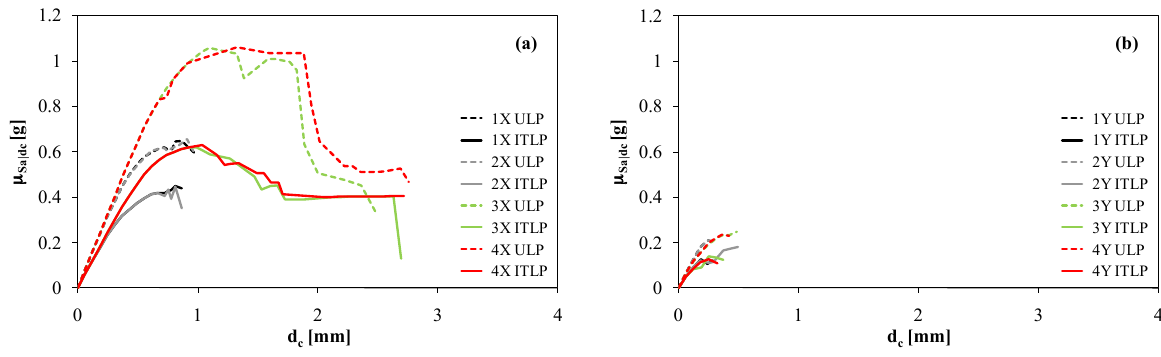
Figure 8. Dispersion of conditional spectral acceleration: ( a ) X-direction; ( b )